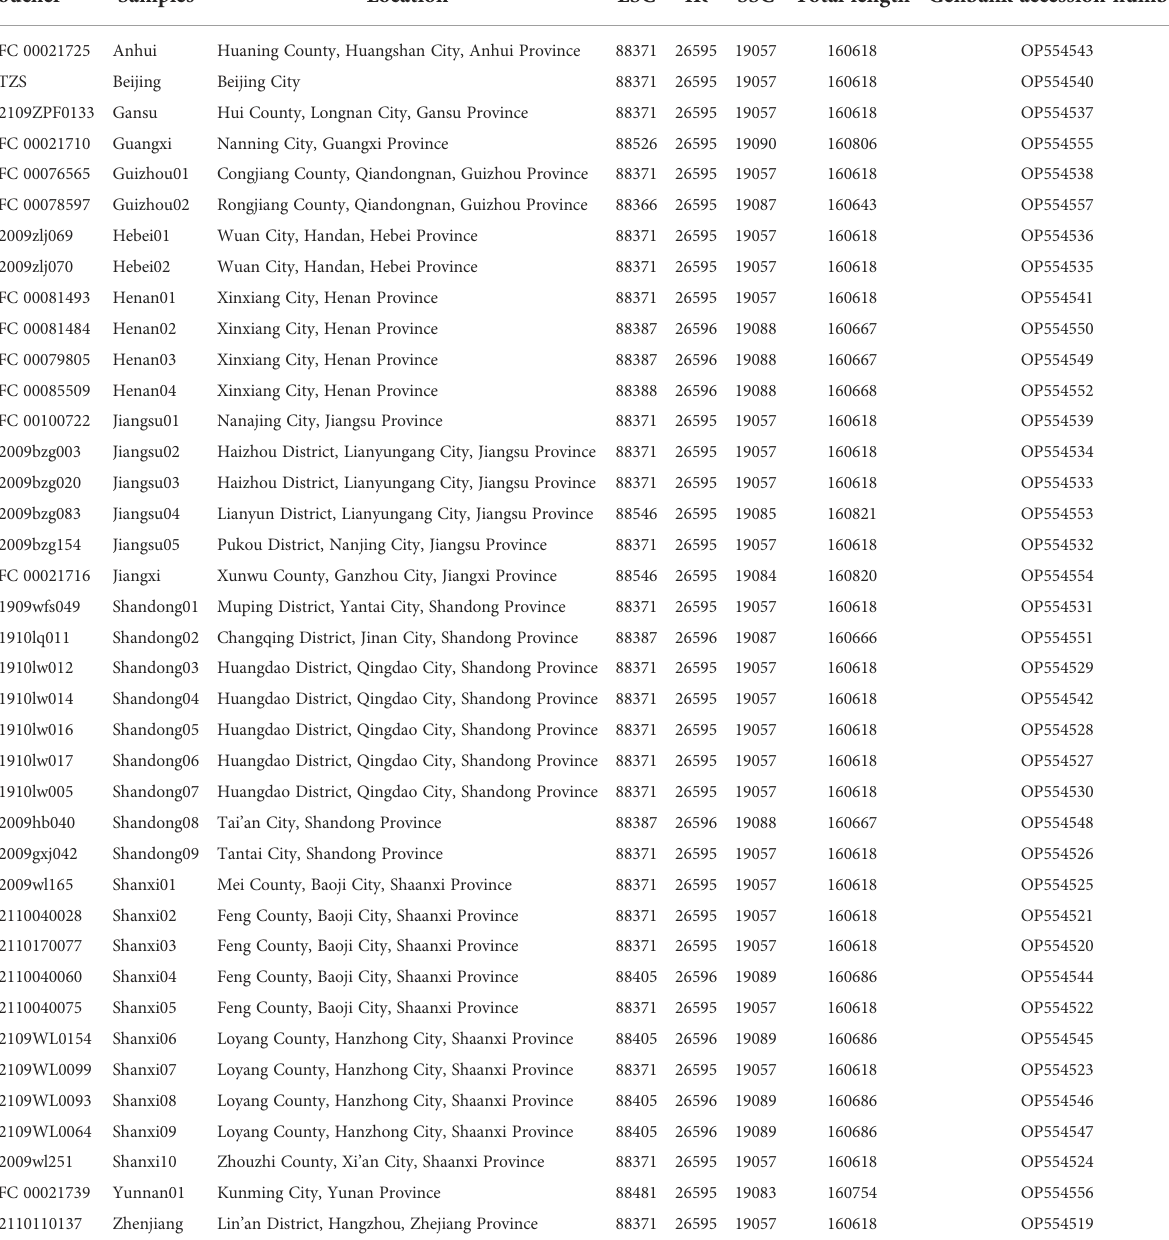
TABLE 1 Sample information and the size of the chloroplast genome